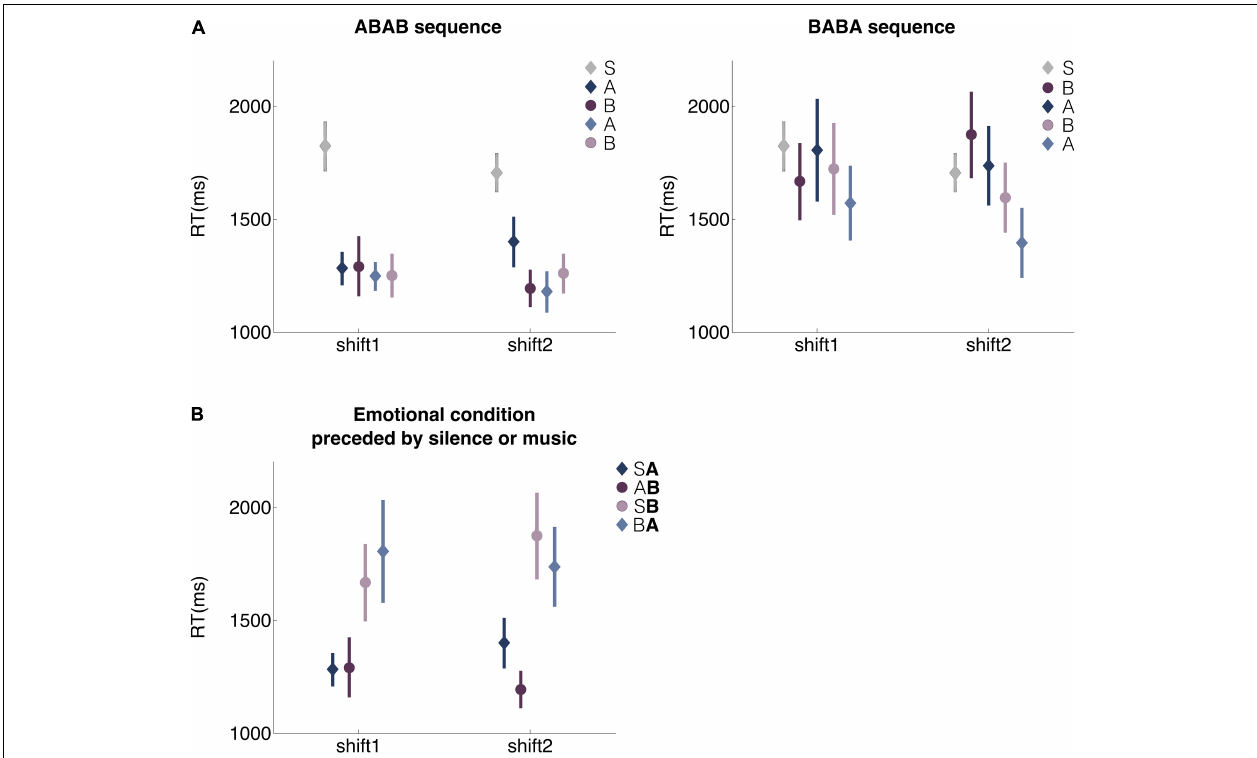
FIGURE 3 | Reaction times for emotional blocks. RTs of shift trials are shown. (A) ABAB and BABA sequence. S: second block of the silent condition. A: block with negative music, high activation, closed stance. B: block with positive music, high activation, open stance. Shift1 and shift2: first and second rule change attempt, respectively. (B) RT for emotional conditions. SA: A emotional condition preceded by silence condition. AB: B emotional condition preceded by A emotional condition. SB: B emotional condition preceded by silence condition. BA: A emotional condition preceded by B emotional condition. Error bars correspond to standard error of the